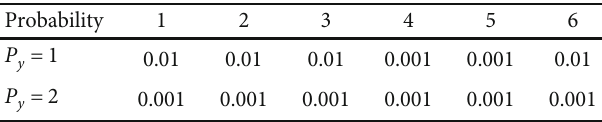
Table 5: Secondary accident probability score results obtained from experts.